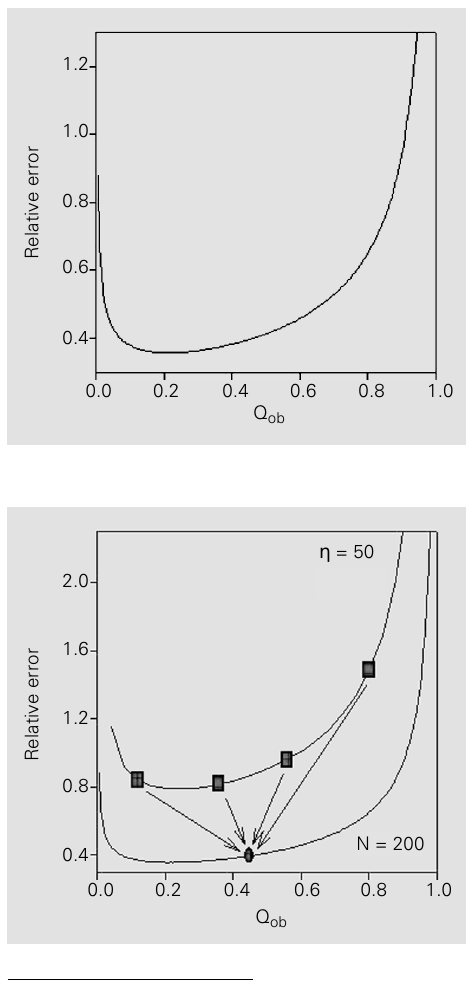
2 Notice that if Q ob = 0, the best one can do is to state “f ≥ z”, thereby defining just one boundary. This implies the need to observe the whole population in order to accept the limit included by such an outcome. Mutatis mutandis , the same applies to Q ob =